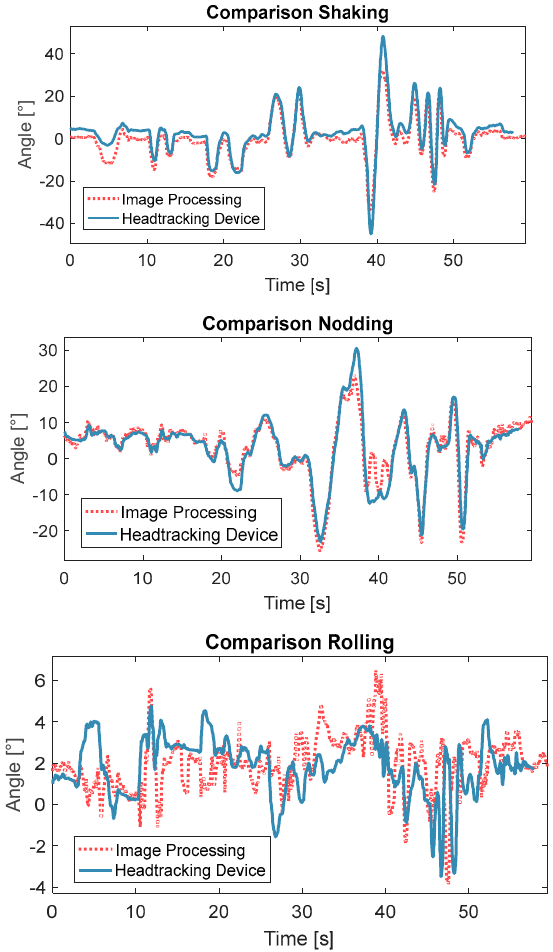
Figure 10. Comparison of head tracking for the proposed head tracking system (blue) and the camera-based tracking system (red) from the in-house experiments.